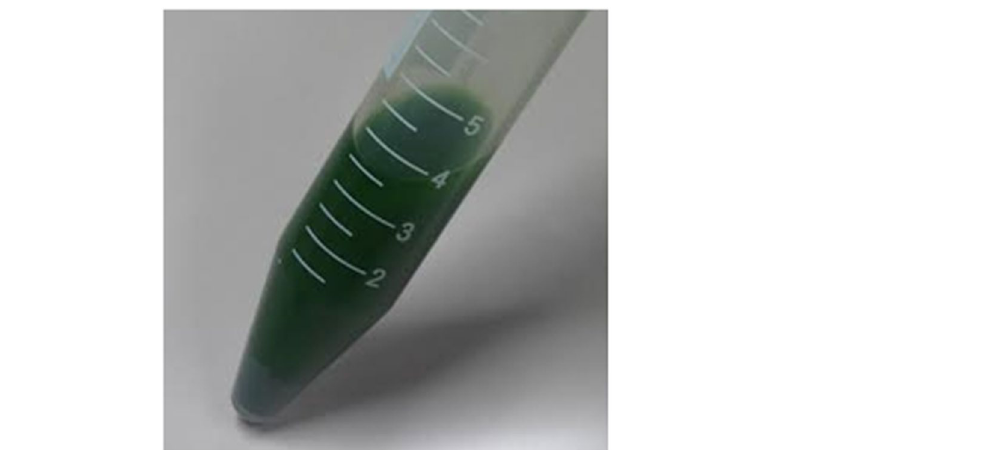
Figure 4. An image of the prepared sample.